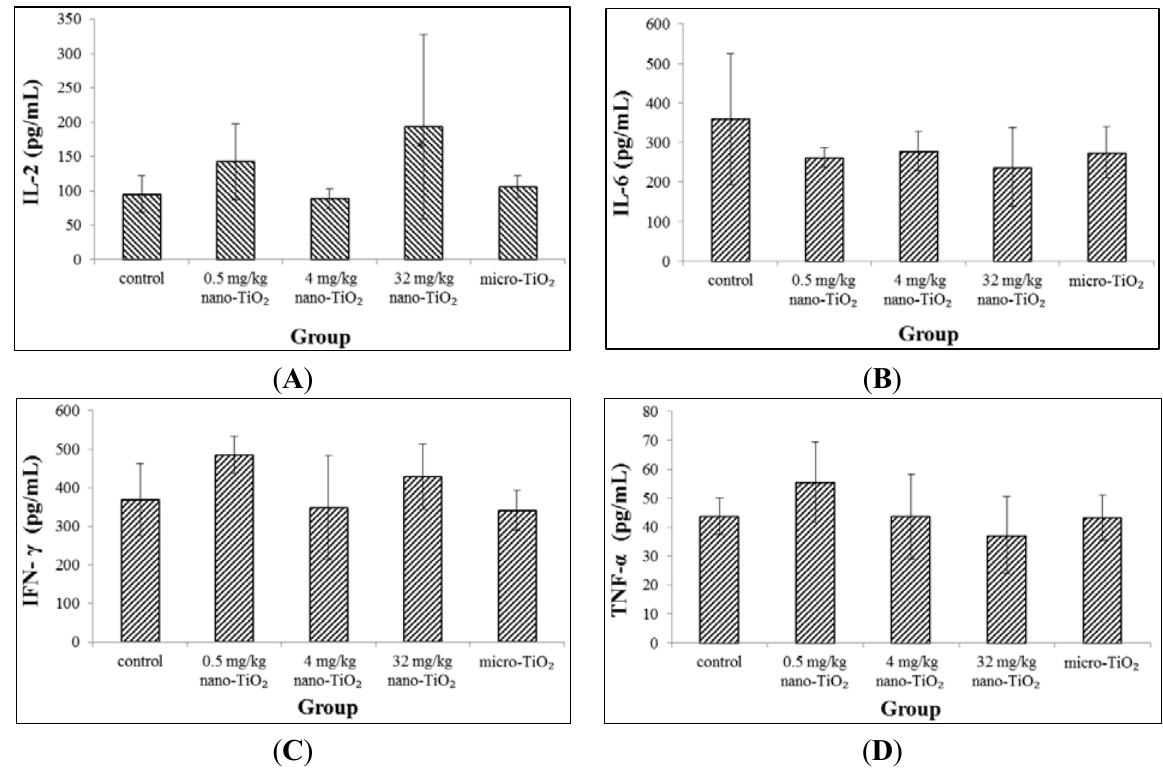
Figure 5. Cytokines expression in the peripheral blood from rats exposed to nano-TiO 28 days by intratracheal instillation. ( A ) the changes of IL-2 expression; ( B ) the changes of IL-6 expression; ( C ) the changes of IFN-γ expression; and ( D ) the changes of TNF-α